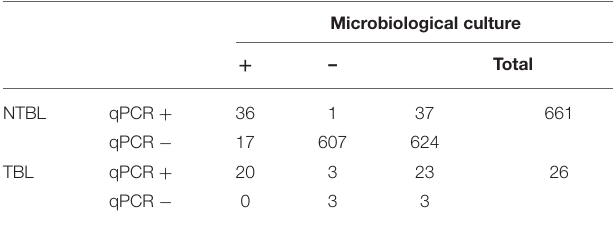
TABLE 4 | Assessment of the microbiological culture and direct qPCR targeting IS 6110 results obtained upon analyzing 687 lymph nodes belonging to 230 cattle, according to the presence or absence of tuberculosis-like